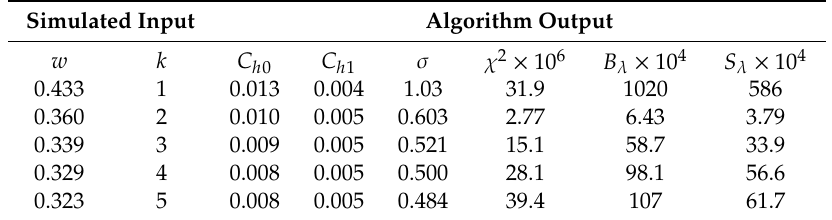
Table 5. Sensitivity results of the algorithm without SRF parameters applied to solar irradiances convolved with di ff erent SRFs.